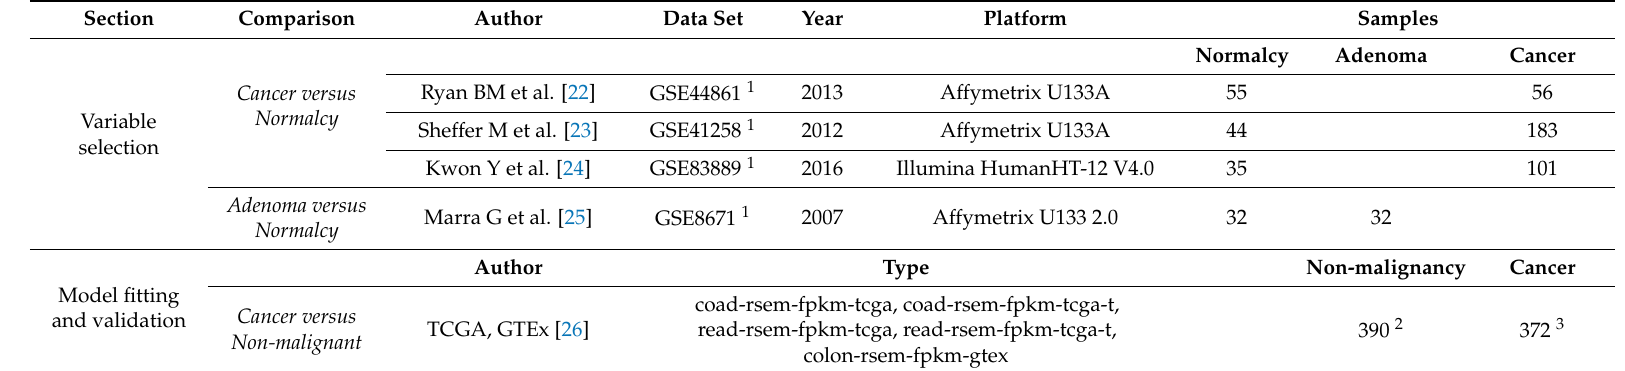
Table 1. Characteristics of the included data set for variable selection and model